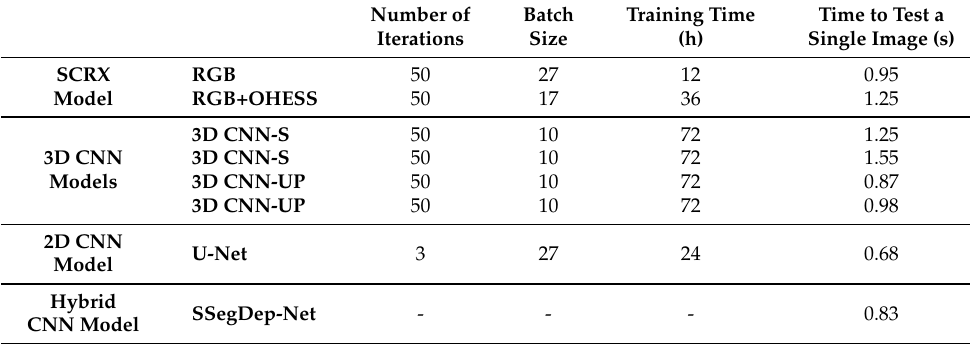
Table 5. Performance comparison for all